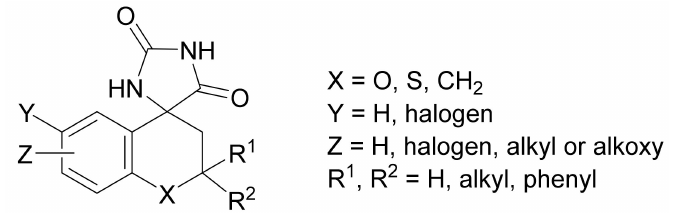
Figure 2. General formula of sorbinil derivatives prepared via Bucherer–Bergs